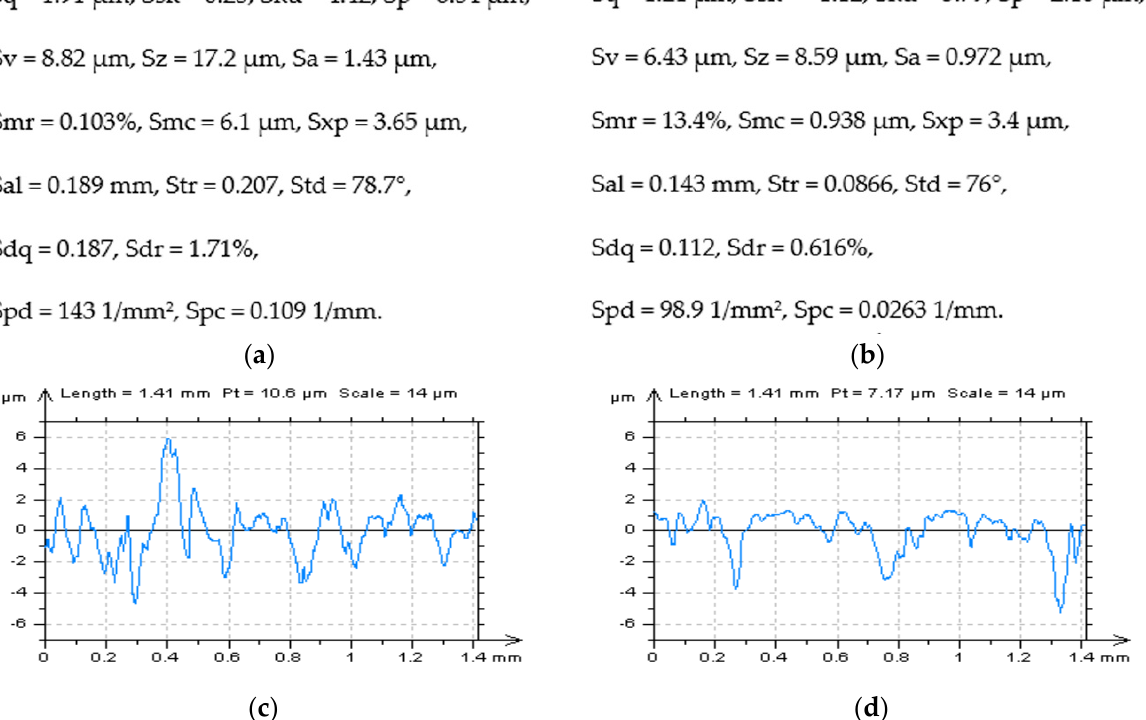
Figure 1. Areas with selected parameters, correspondingly, and profiles of measured by the stylus ( a , b ) or optical ( c , d ) instruments surface topographies of zero-wear ( a , c ) and running-in ( b , d ) plateau-honed cylinder liner textures.